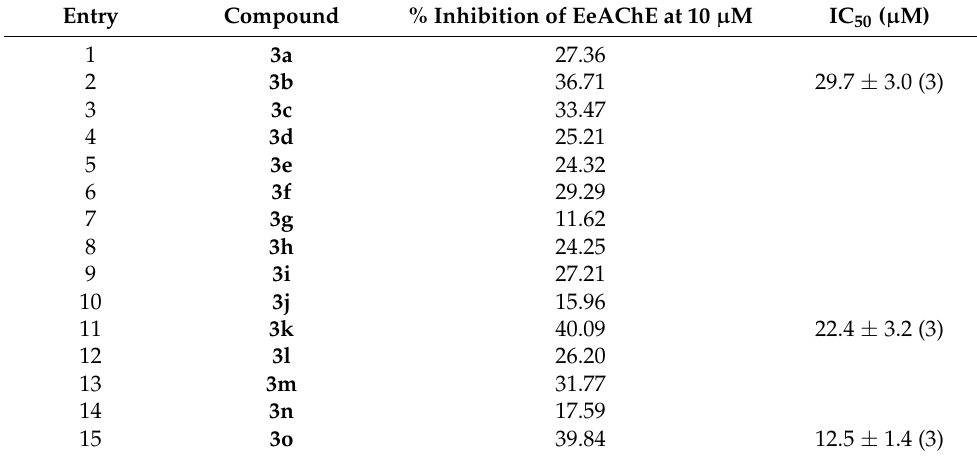
Table 3. Anticholinesterase activity of compounds 3